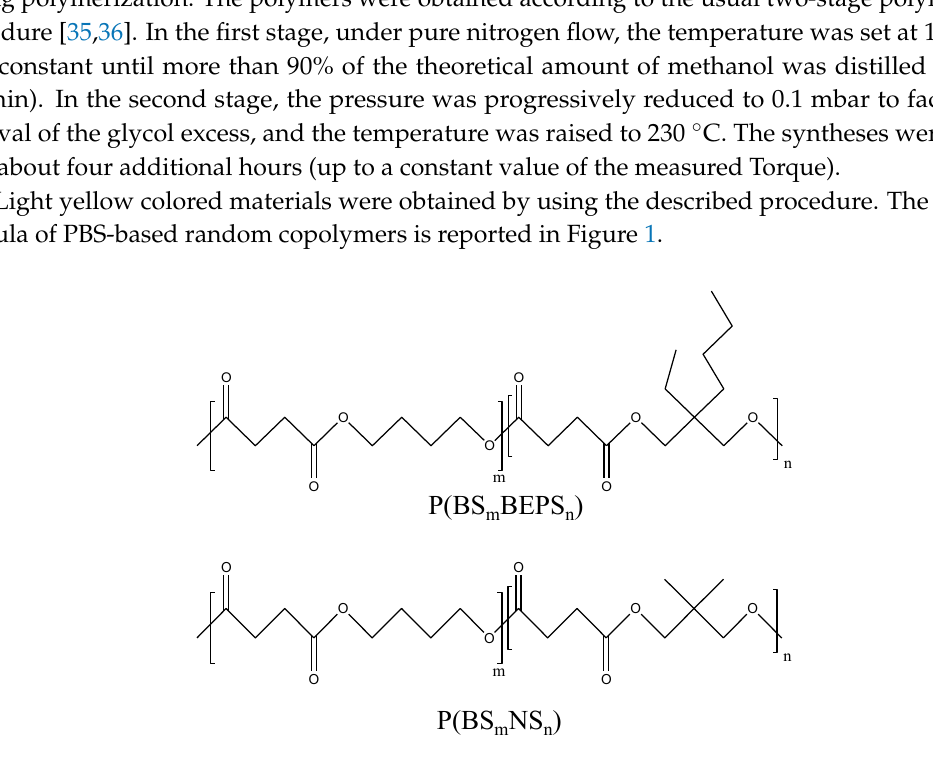
Figure 1. Chemical structures of P(BS m BEPS n ) and P(BS m NS n ) random copolymers.